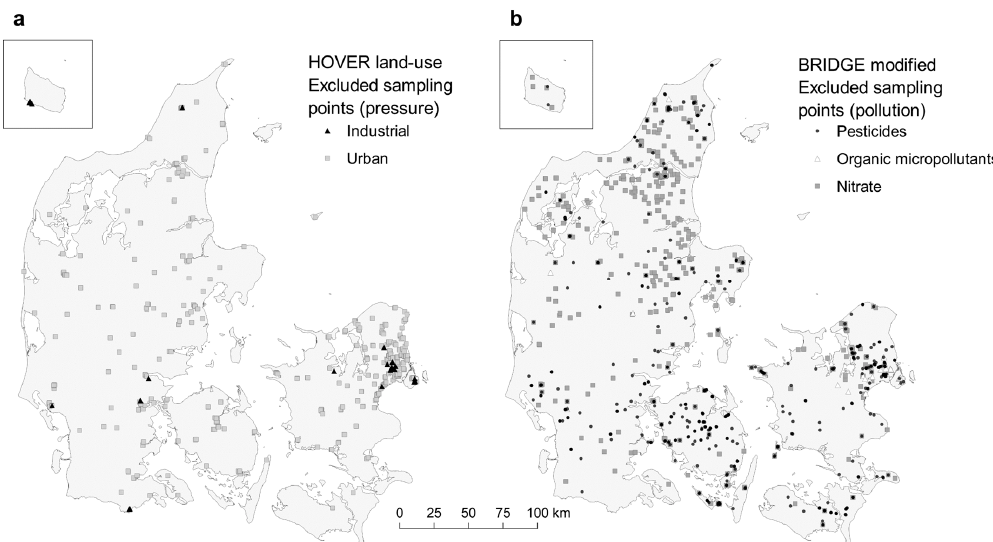
Figure 6. Location of sampling points that were excluded when calculating NBLs for the HOVER land-use ( a ) and the BRIDGE modified ( b ) methods.